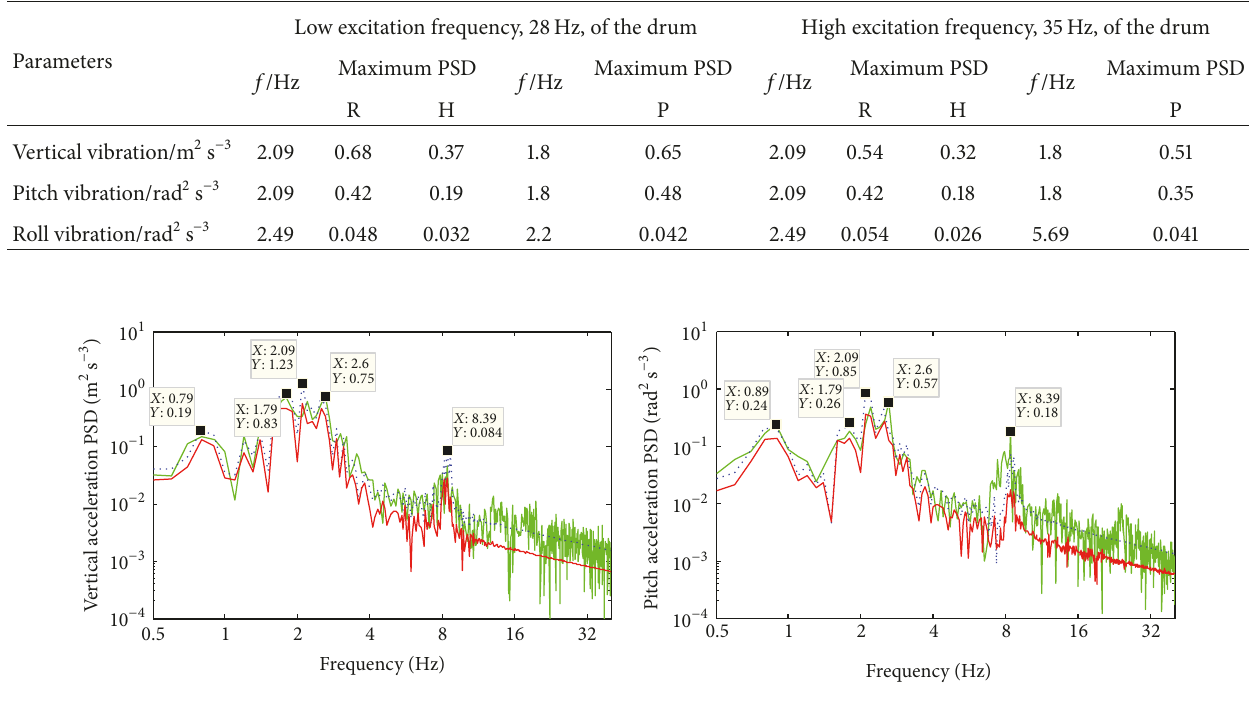
Table 8: The maximum PSDs of the acceleration responses with three cab’s isolation mounts.